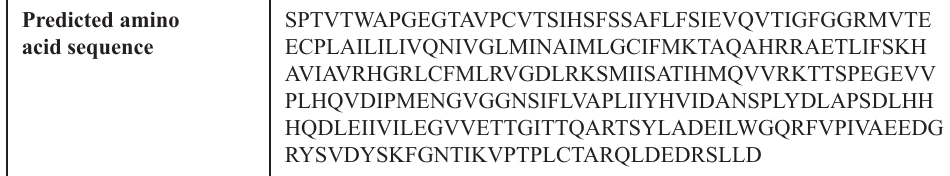
Figure.3. Predicted amino acid sequence of exon region of KCNJ 11 gene